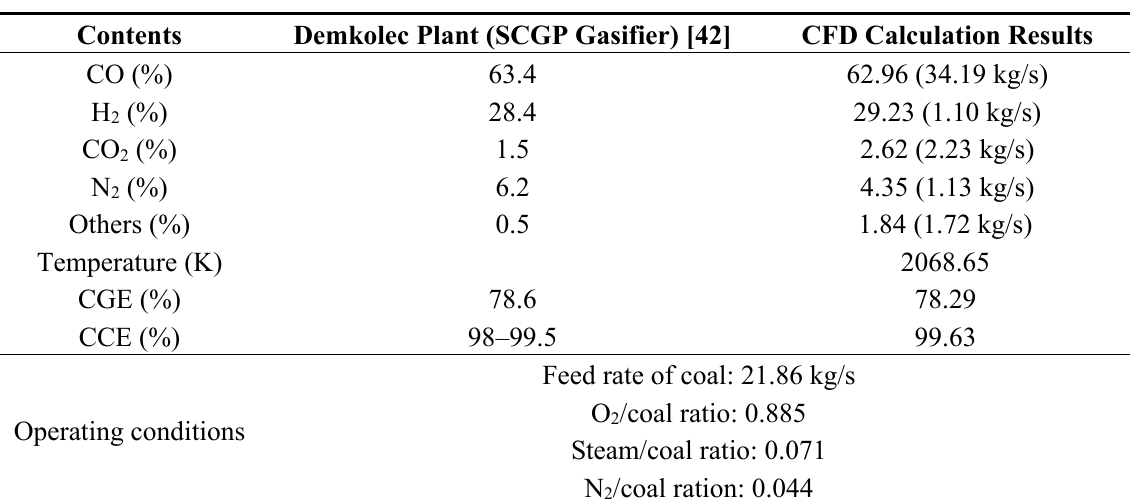
Table 5. Comparison of the CFD results with actual operating data from Demkolec demo IGCC